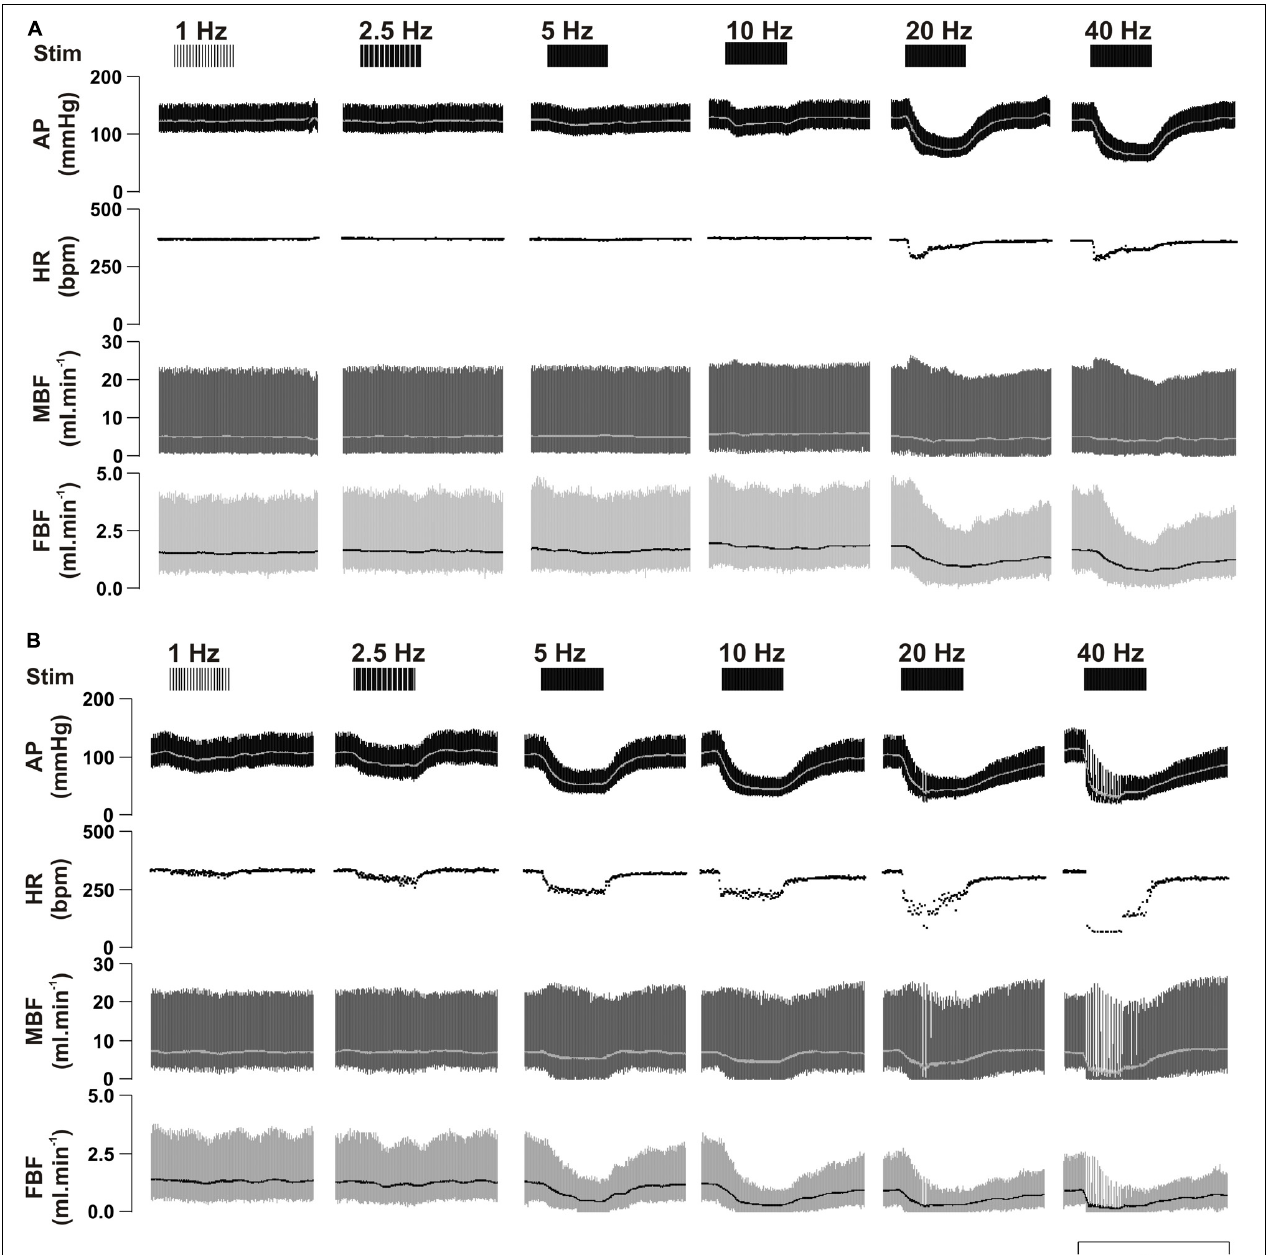
FIGURE 2 | Representative raw data traces showing the effect of left aortic depressor nerve (ADN) stimulation (1, 2.5, 5, 10, 20, and 40 Hz at 0.4 mA, 0.2 ms for 20 s) on cardiovascular parameters measured in urethane-anaesthetized male (A) and female (B) Sprague Dawley (SD) rats. Simulation (Stim), arterial pressure (AP), heart rate (HR), mesenteric blood flow (MBF) and femoral blood flow (FBF).